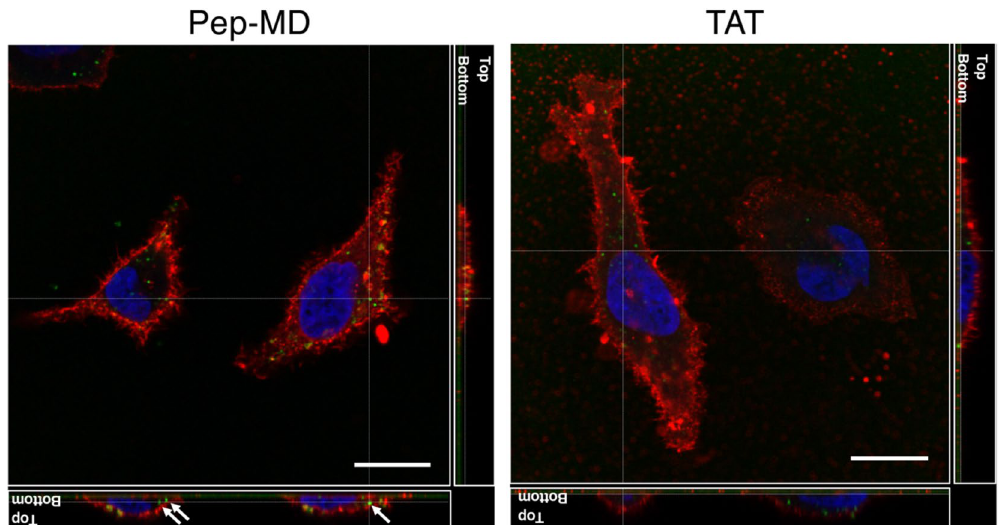
Figure 3. Intracellular distribution of Pep-MD and TAT at single-cell resolution using confocal laser scanning microscopy (left and right, respectively). The arrows in the left figure indicate green fluorescence spots corresponding to Pep-MD inside the cell membrane (red fluorescence), clearly indicating that Pep-MD is cell